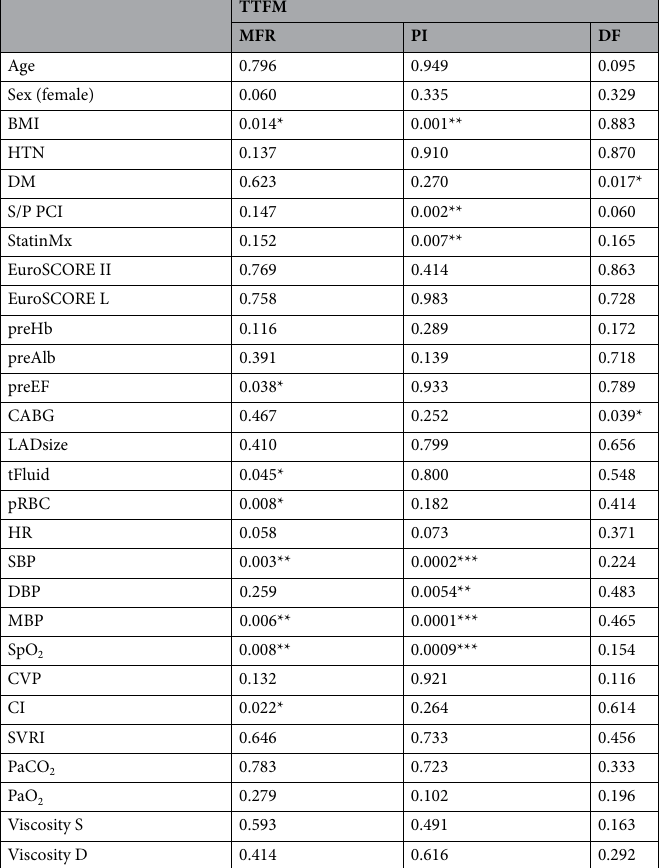
Table 3. The p value for the effect of perioperative factors on several parameters of TTFM at the graft from LIMA to LAD. TTFM transit-time flow measurement, MFR mean flow rate measured, PI